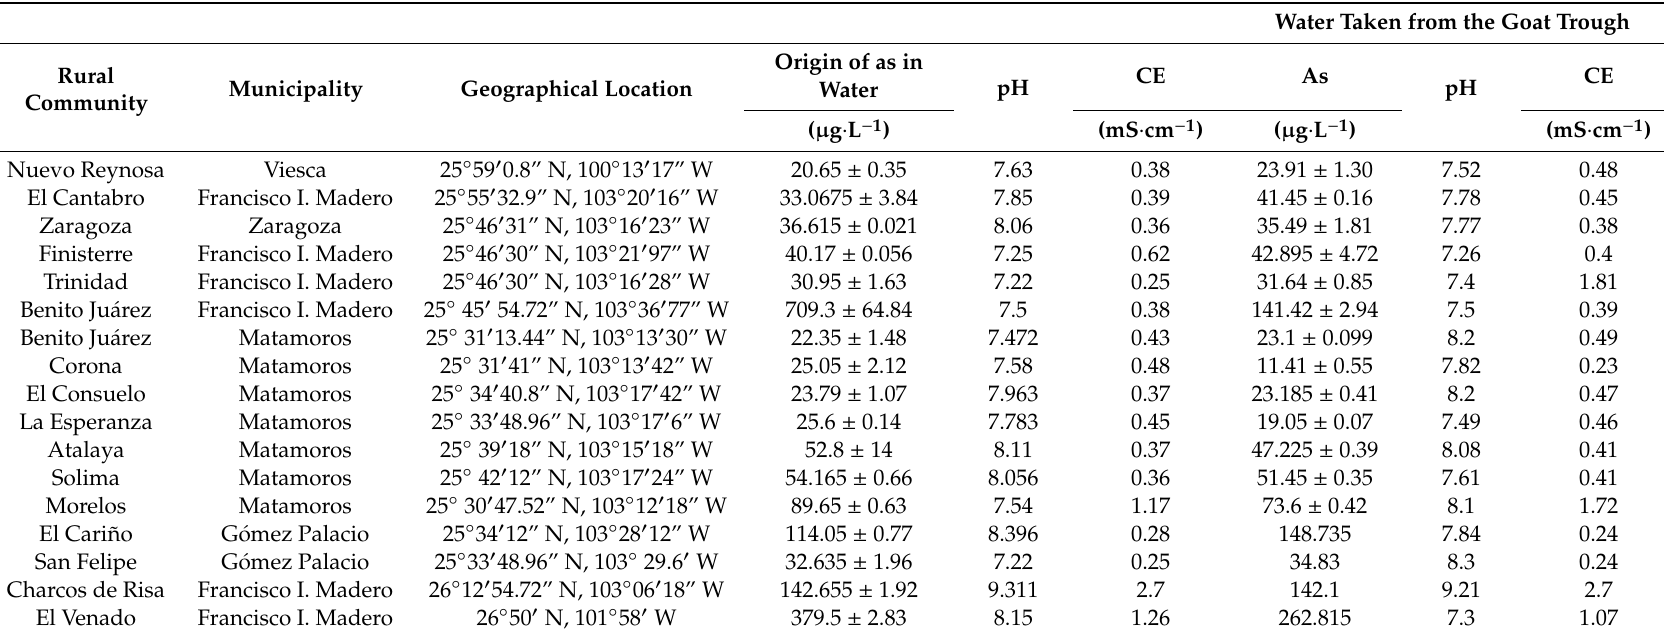
Table 1. Arsenic concentration, pH and Electrical Conductivity (EC) in water samples taken from rural communities in the Region Lagunera.